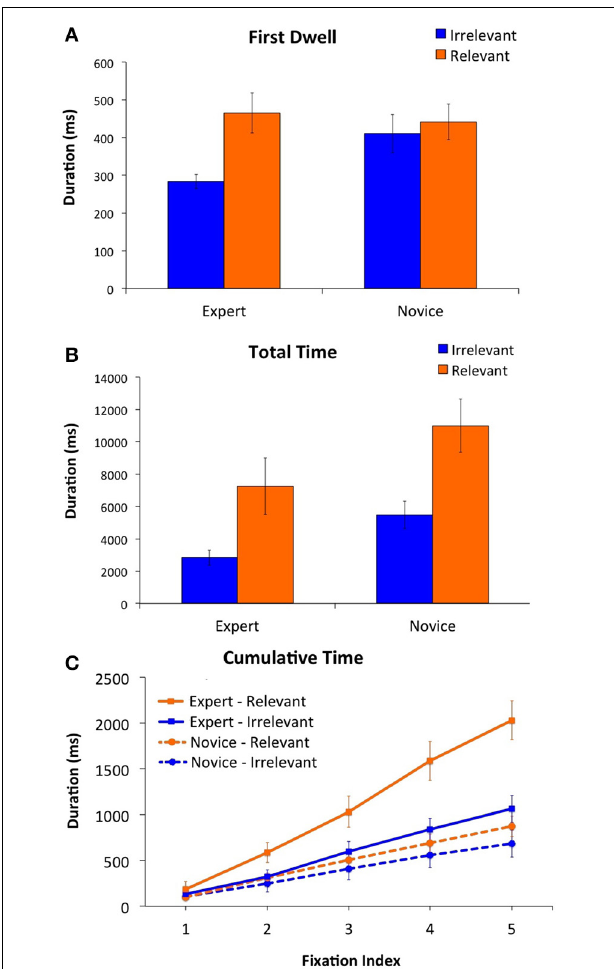
FIGURE 1 | The duration of the First Dwell (A) Total Time (B), and the Cumulative Time of the first five ordinal fixations in the trial (C) as a function of relevancy (relevant vs. irrelevant) and level of expertise (expert,